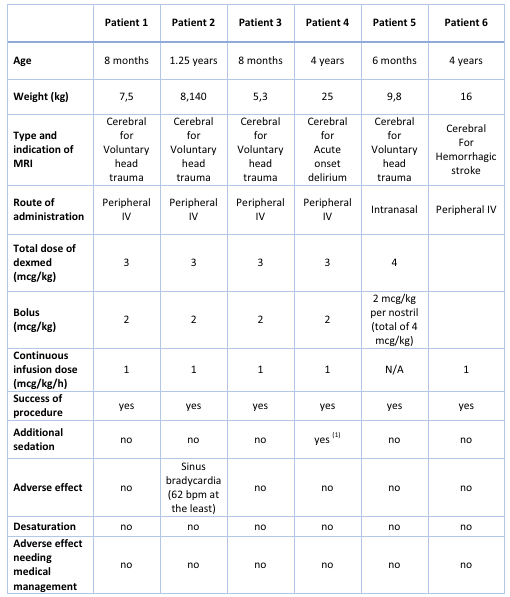
Table 1 Patient cases description and dexmedetomidine use